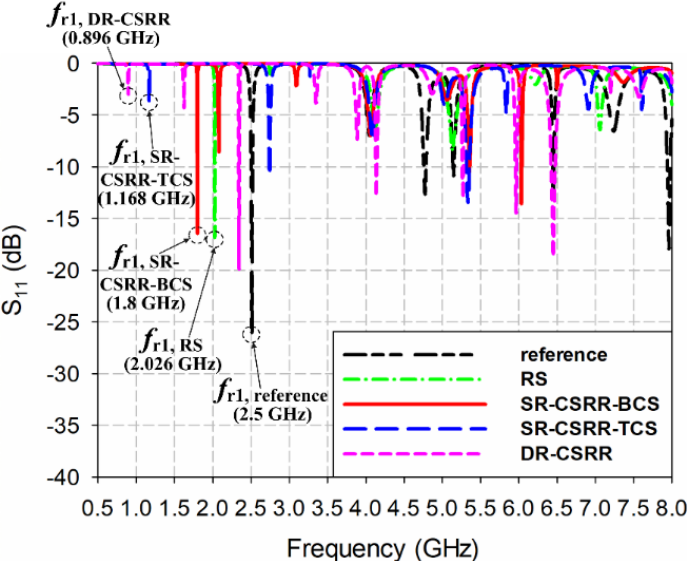
Figure 2. Comparison of the input reflection coefficient characteristics for the reference rectangular MPA with the four MPAs loaded with different slots.